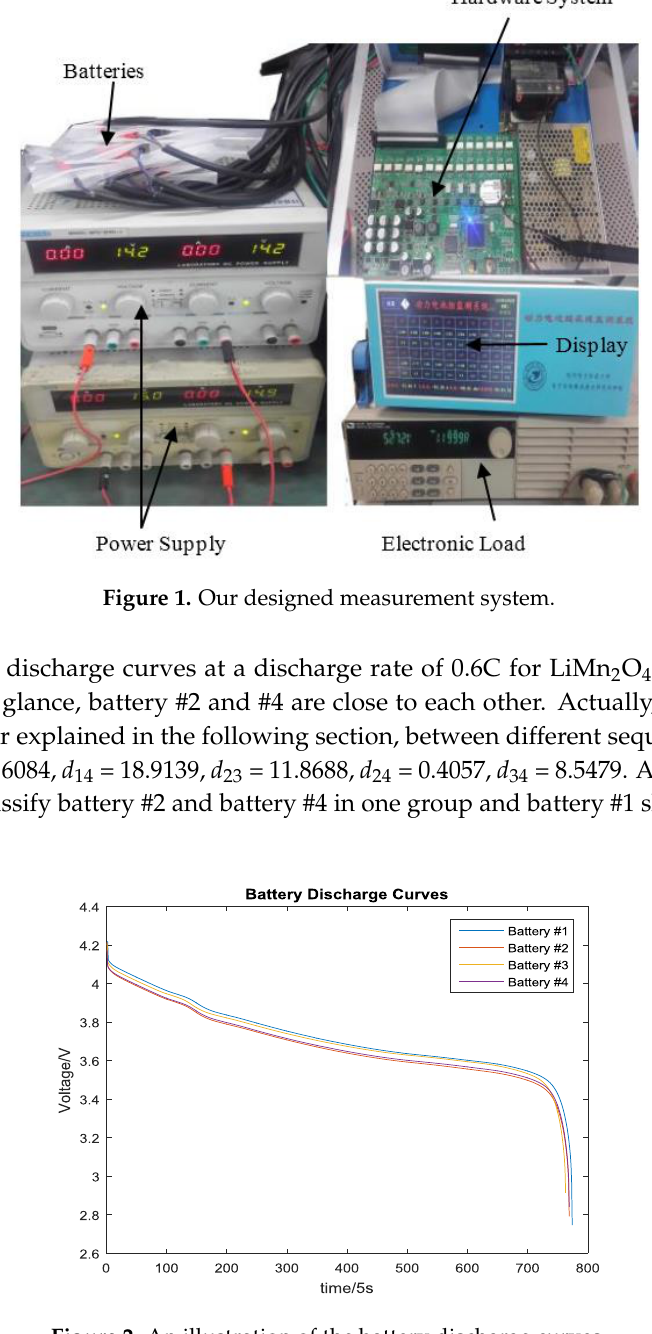
Figure 2. An illustration of the battery discharge curves.